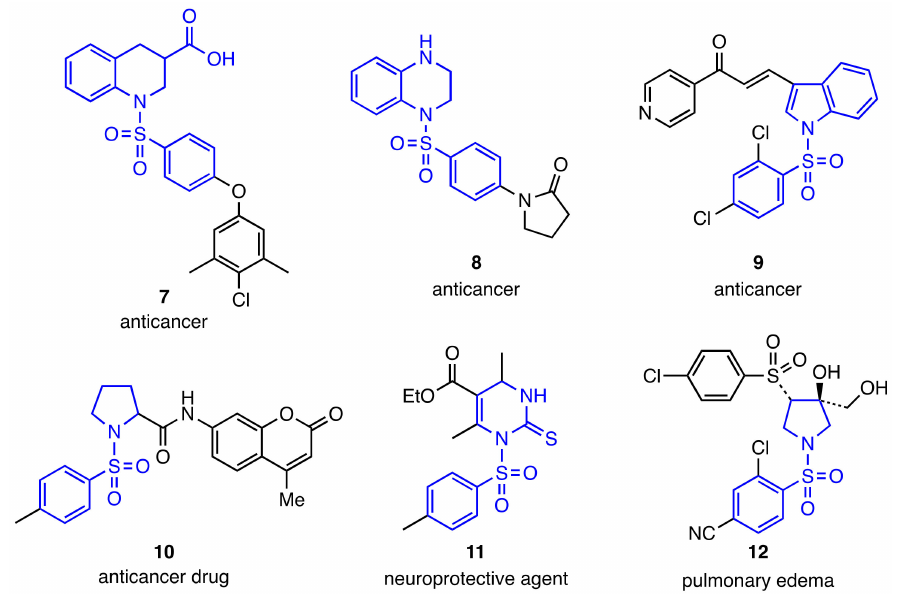
Figure 1. Experimental drugs incorporating tertiary cyclic sulfonamides (highlighted in blue).